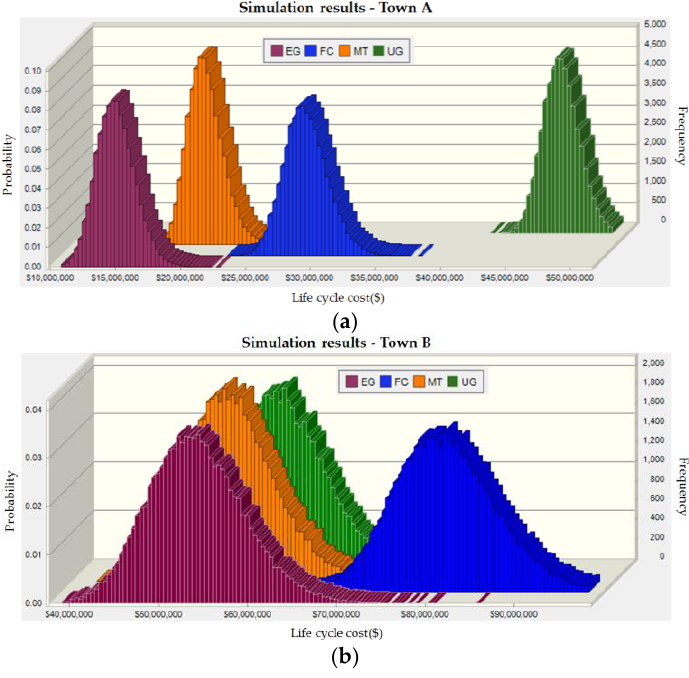
Figure 5. Graphical comparisons of Monte Carlo simulation results: ( a ) Town A; and ( b ) Town B. Table 4. Monte Carlo simulation results for Town A. Std.: standard and Err.: error.